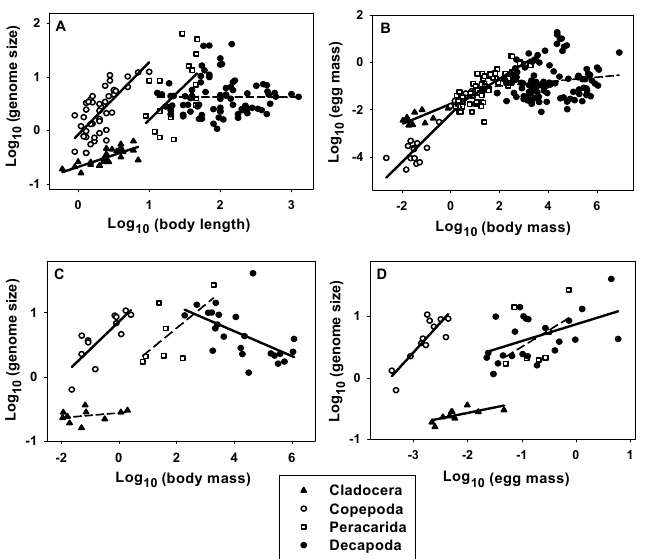
Figure 1. Log-linear relationships between genome size (pg) and body length (mm) ( A : data from [57]), wet egg mass (mg) and wet adult (maternal) body mass (mg) ( B : data from [101]), genome size and wet body mass ( C : data from [101,102]), and genome size and wet egg mass ( D : data from [101,102]) for four major crustacean taxa. Solid and dashed lines indicate significant and non-significant linear regressions, respectively (details in Table 2).